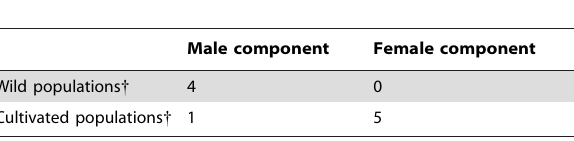
Table 2. Numbers of examples in which the primary mutations involved in the loss of SI are attributable to male or female components of